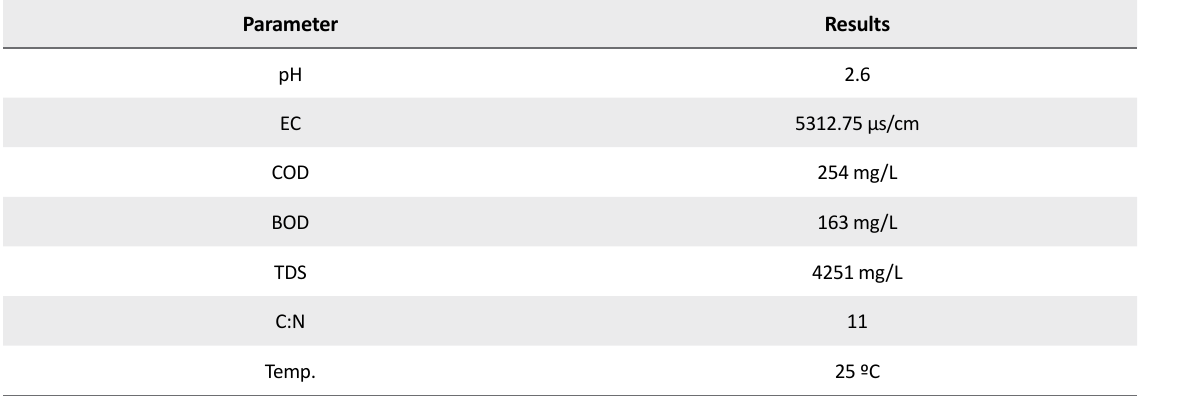
Table 2. Physical and chemical properties of wastewater at a temperature of 25±1 °C Parameter